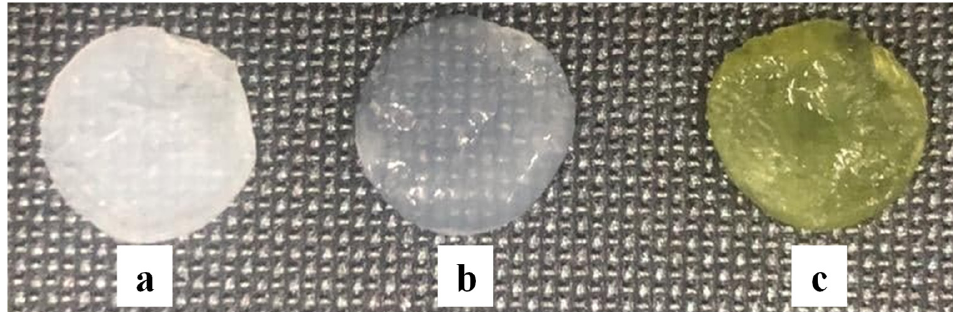
Figure 3. The aspect of bacterial cellulose (BC) film: ( a ) filter-paper-pressed film; ( b ) native purified BC film; ( c ) BC enriched with ethanolic herbal extract.